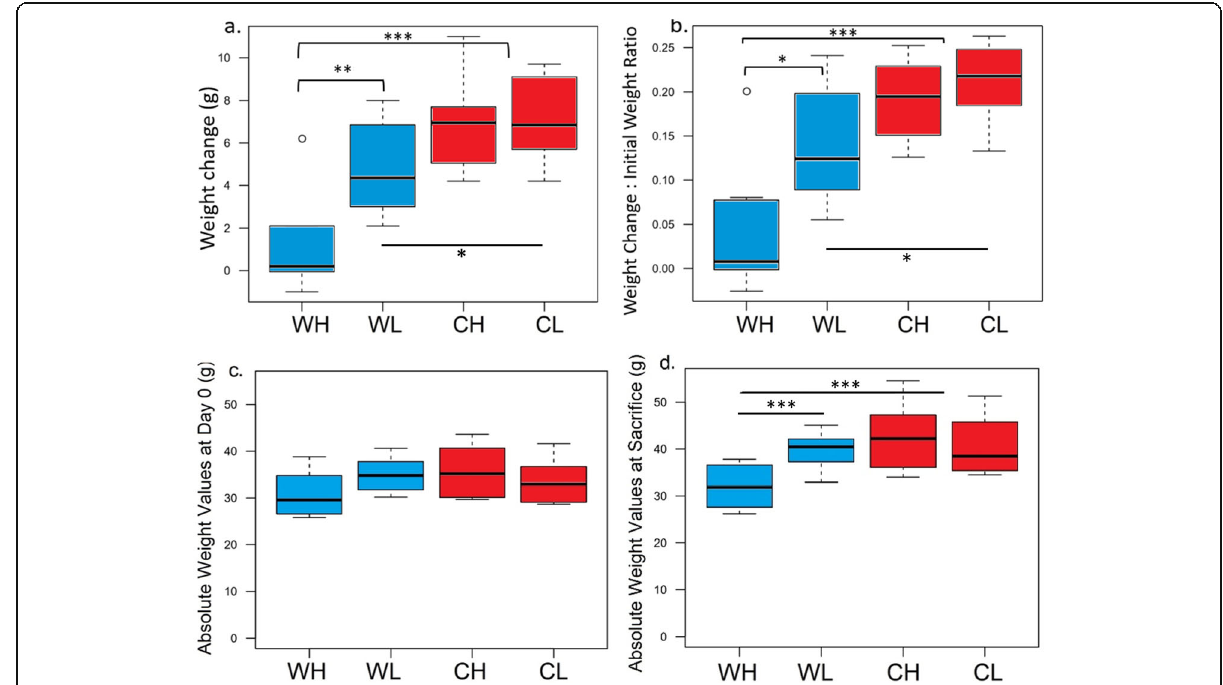
Fig. 2 Weight gain in mice from the beginning of the study to sacrifice. Captive donor mice on either diet showed significantly greater weight gain than mice receiving the wild donor microbiota (t-test for group comparisons, two-way ANOVA for diets vs. FMT sources, * p<0.05; ** p<0.01; ***